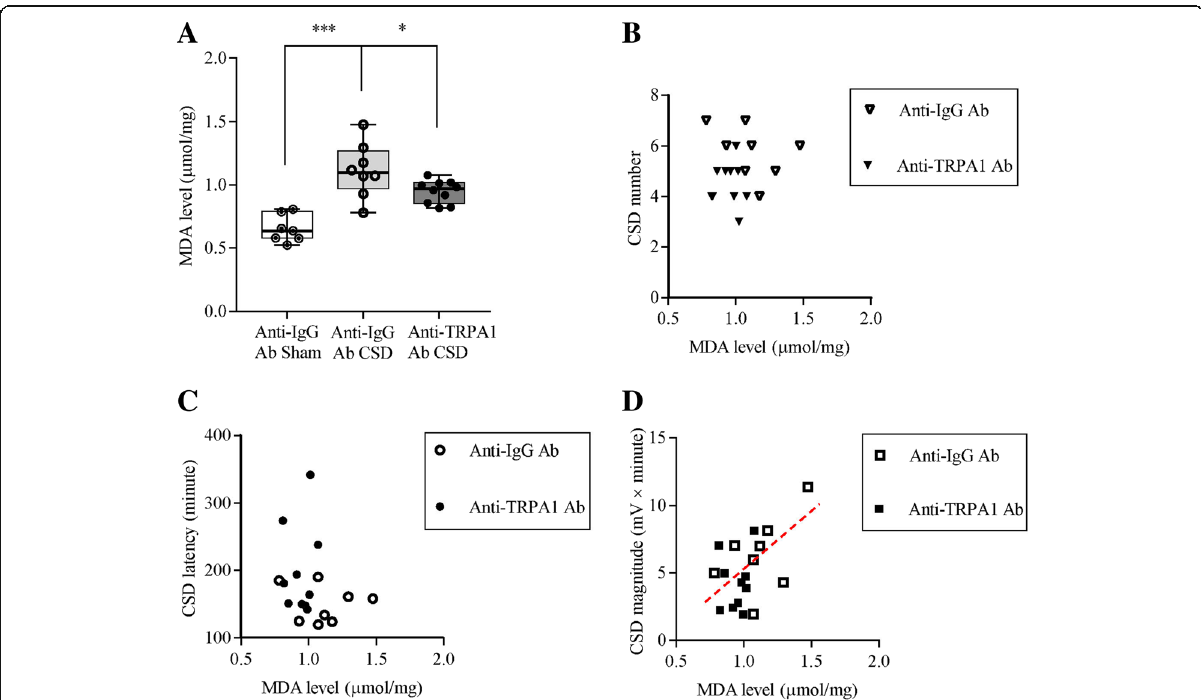
Fig. 4 Effects of the anti-TRPA1 antibody on MDA level ( μ mol/mg protein) induced by CSD in the ipsilateral cerebral cortex of rat and correlation analysis of each CSD characteristic with levels of cortical ipsilateral MDA between the anti-TRPA1 antibody or anti-IgG antibody groups. a CSD promoted ipsilateral cortical MDA level, which was inhibited by the pretreatment of anti-TRPA1 antibody perfused into the contralateral i.c.v in rats. Mann-Whitney U test, one-tailed, for significance between each group (* p < 0.05, *** p < 0.001). The reduced CSD magnitude ( d ), but not CSD number ( b ) and latency ( c ) positively correlated with a lower MDA level after the anti-TRPA1 antibody perfusion. Red dotted lines indicated positive correlation between CSD magnitude and MDA